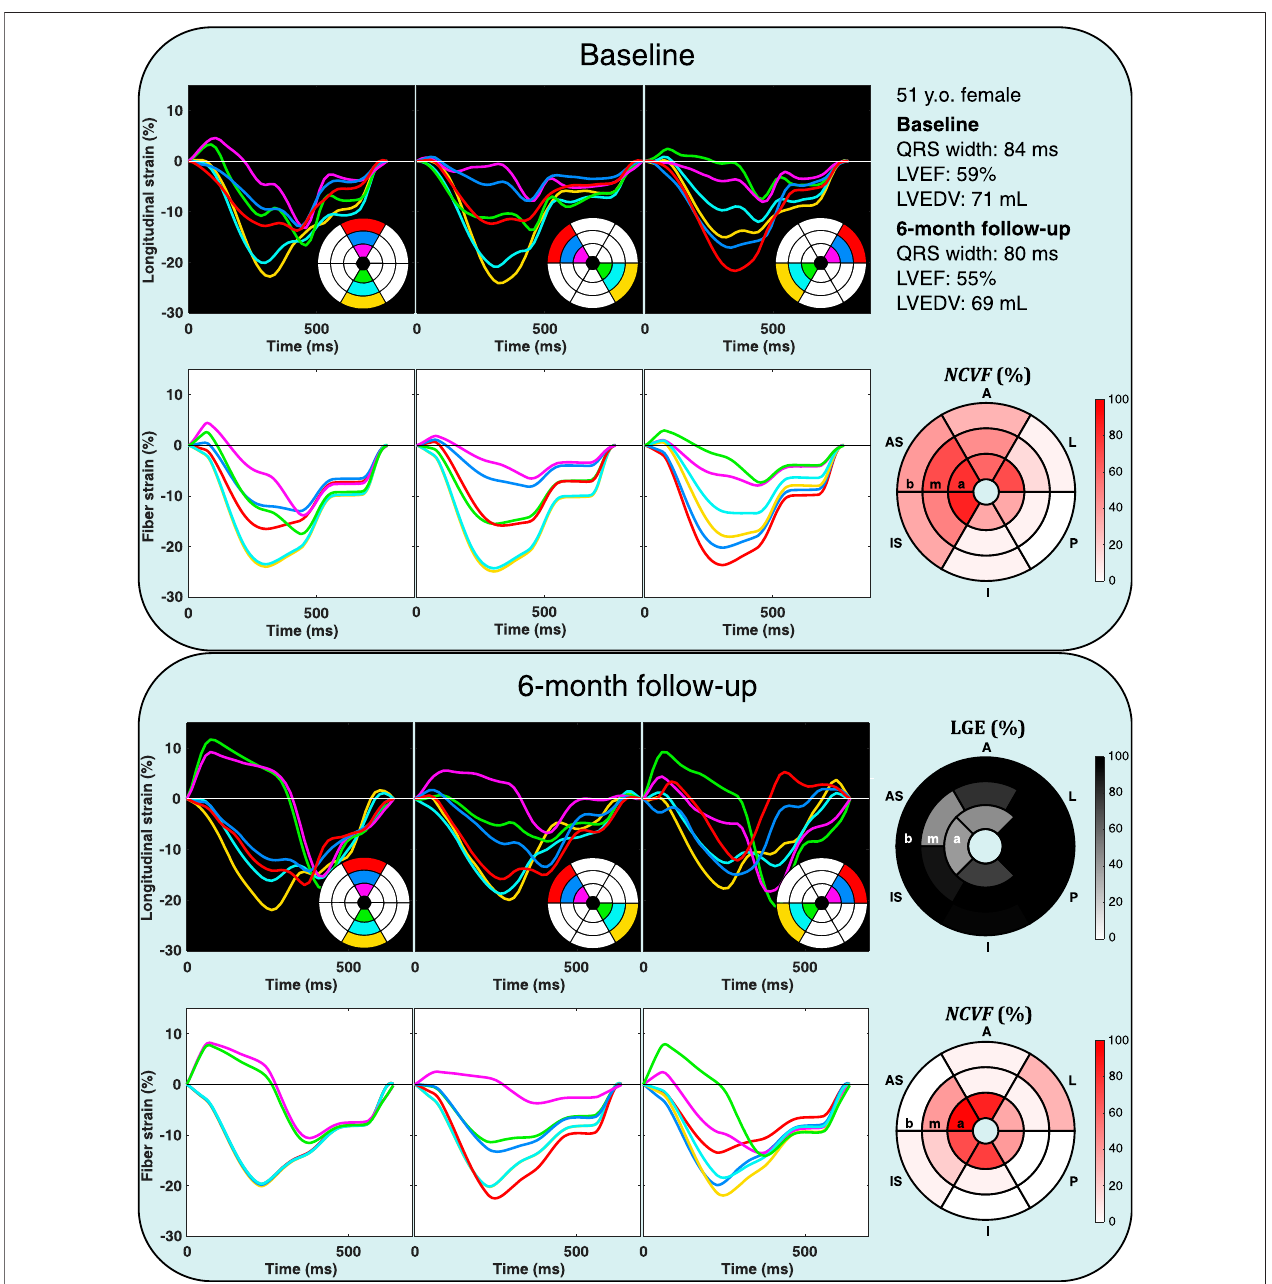
FIGURE 9 | Echocardiographic strain measurements (black panels) and simulated strain patterns obtained using an optimization algorithm (white panels) at the baseline and 6-month follow-up in one patient from the DEFI-MI subcohort (patient 2, a 51-year-old female). Estimated NCVF values at the baseline were higher in the anterior (A), anteroseptal (AS), and inferoseptal (IS) wall segments and in the apical (a) inferior (I), posterior (P), and lateral (L) wall segments than in the rest of the heart. After 6 months, the scar tissue was found using late gadolinium enhancement (LGE) in a part of this dysfunctional area, extending from the apex into the mid- ventricular (m) anteroseptal segment. Increased values of the NCVF were remained in these scarred segments. b, base.